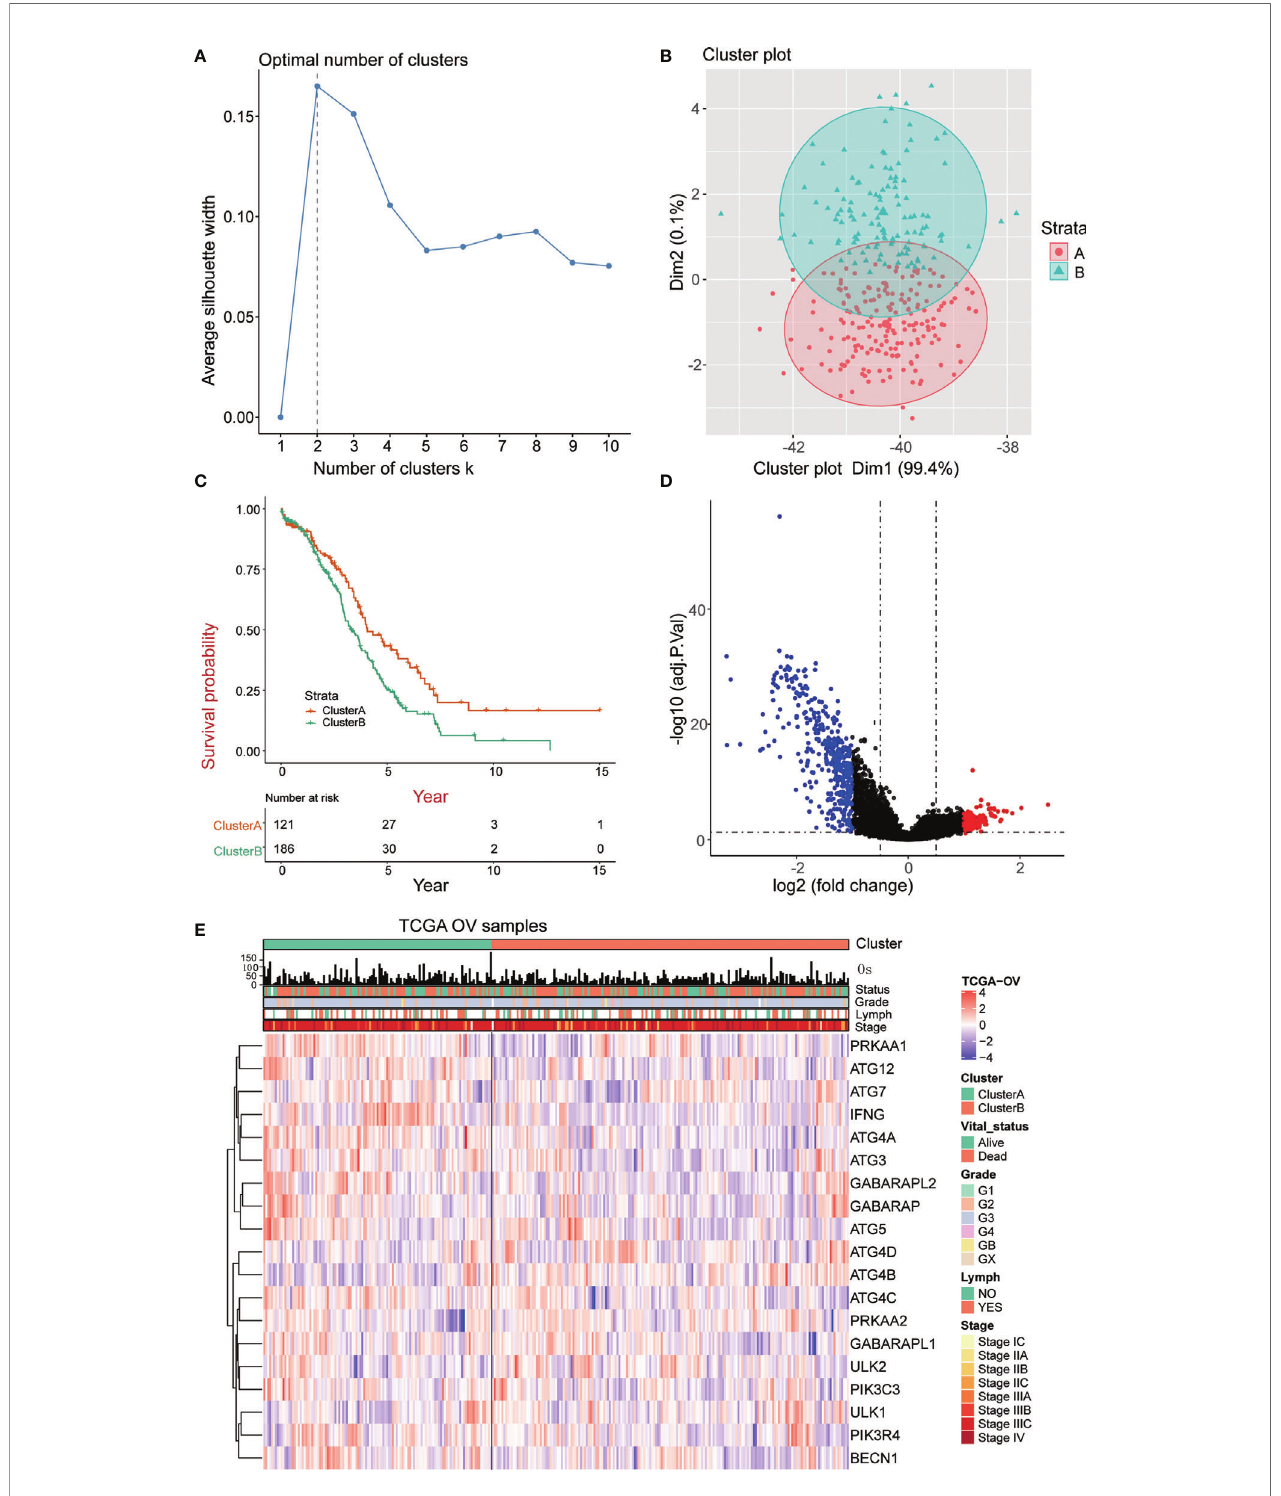
FIGURE 2 | Identi fi cation of OC subtypes using k-means consensus clustering of the metadata set. (A, B) k-means clustering of OC based on the estimated abundance of 19 ARGs. (C) Kaplan ‐ Meier curves of the overall survival of the different gene subtypes. (D) Volcano plot of the identi fi ed differentially expressed genes (| logFC> 1, adjusted P <0.05). Red and blue dots indicate upregulated (N=108) and downregulated genes (N=427) in OC, respectively. (E) The heatmap shows the associations between the ARGs and the clinical characteristics (age, grade, lymphovascular invasion indicator, primary site and clinical stage) in the TCGA database. (Lymph = lymphovascular invasion